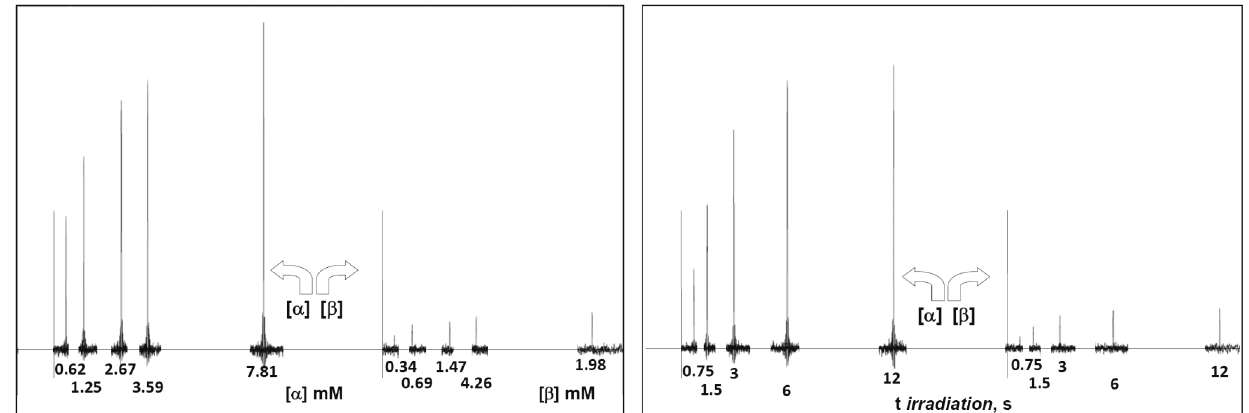
Figure 2. ( Left ) Serial STD spectra as a function of ligand concentration obtained at 300 K, 0.09 mM ConA and 3 s saturation time with anomeric percentages of 64.5% and 35.5% for (cid:3)-2FDM and (cid:5)-2FDM, respectively. The concentration of each anomer is below each signal, and each spectrum is shifted proportionally to the variable condition (ligand concentration); ( Right ) Serial STD difference spectra as a function of saturation time obtained at 290 K with 0.09 mM ConA and 12.1 mM total concentration of 2DFM with 65.8% and 34.2% for (cid:3) and (cid:5) anomer, respectively; the saturation time of each experiment is below each signal, and each spectrum is shifted proportionally to the variable condition (spin irradiation